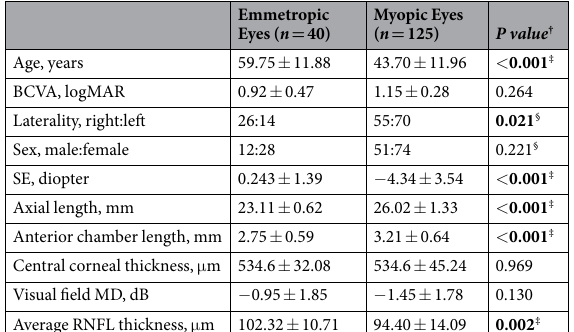
Table 2. Baseline characteristics of the emmetropic eyes and the myopic eyes * . BCVA: best-corrected visual acuity; logMAR: logarithm of the minimum angle of resolution; SE: spherical equivalent; MD: mean deviation of perimetry; RNFL: retinal nerve fiber layer. * Data are presented as mean ± standard deviation unless otherwise indicated. † Independent t -test for continuous variables. ‡ Statistically significant values ( P < 0.05) are shown in bold. § χ ² test for categorical variables.